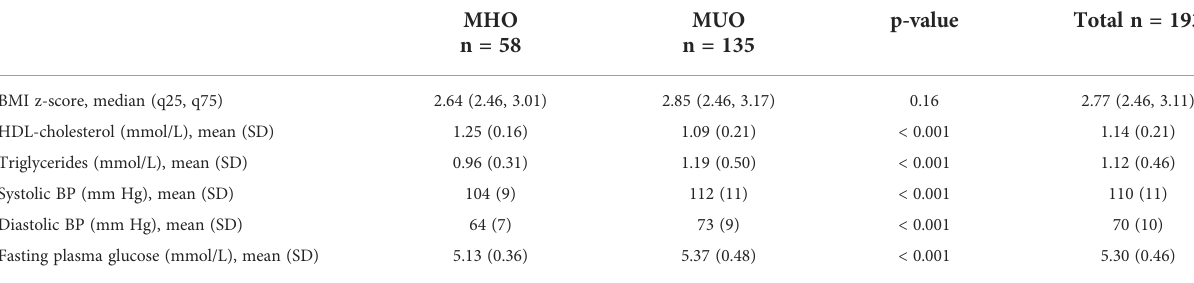
TABLE 1 Comparison of parameters used as criteria to de fi ne metabolically healthy obese (MHO) and metabolically unhealthy obese (MUO)